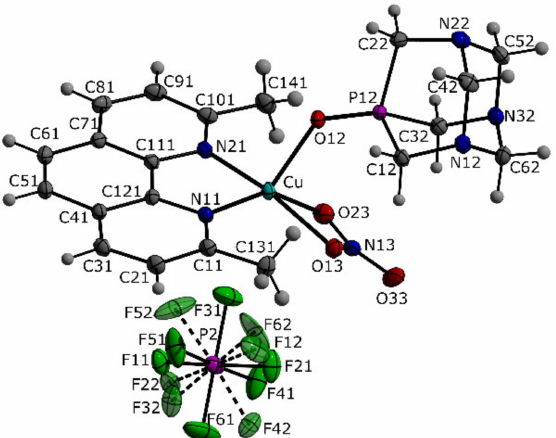
Figure 1. Molecular structure of compound 1 . Ellipsoids shown at the 50% probability. Color code: Grey, carbon; blue, nitrogen; red, oxygen; violet, phosphor; green, fluoride; cyan, copper; light grey, hydrogen. Selected bond lengths [Å] and angles [ ◦ ]: Cu-N21, 1.972(1); Cu-N11, 1.995(1); Cu-O12, 2.102(1); Cu-O13, 2.028(1); Cu-O23, 2.083(1); P12-O12,1.506(1); N11-Cu-N21, 84.66(5); Cu-N11-C11, 130.80(9); Cu-O12-P12, 134.23(7); N11-Cu-O12, 112.83(4); N11-Cu-O13, 102.90(5); N11-Cu-O23, 148.04(5); N11-Cu-O12, 100.93(5); N21-Cu-O13, 161.17(5); N21-Cu-O23, 101.54(5); N21-Cu-O13, 92.08(4); O12-Cu-O23, 96.90(5); O13-Cu-O23,